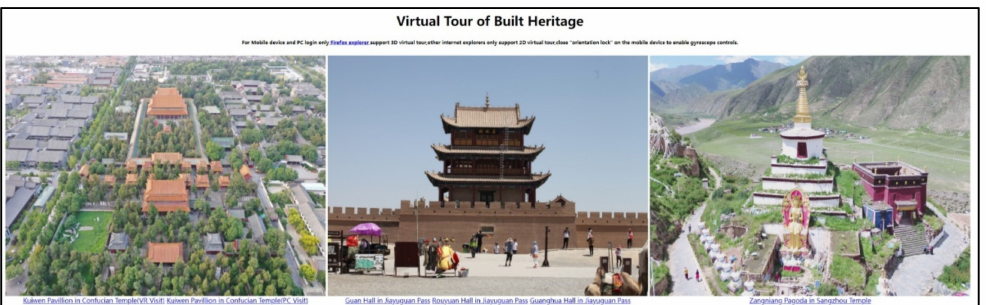
Figure 11. The codes of the index page.